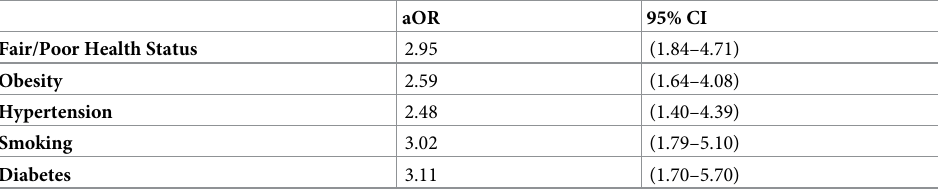
Table 5. Multivariate logistic regression of associations between depression and physical health status and condi- tions among female patients with depression of reproductive age (15–49 yrs) served at HRSA funded health